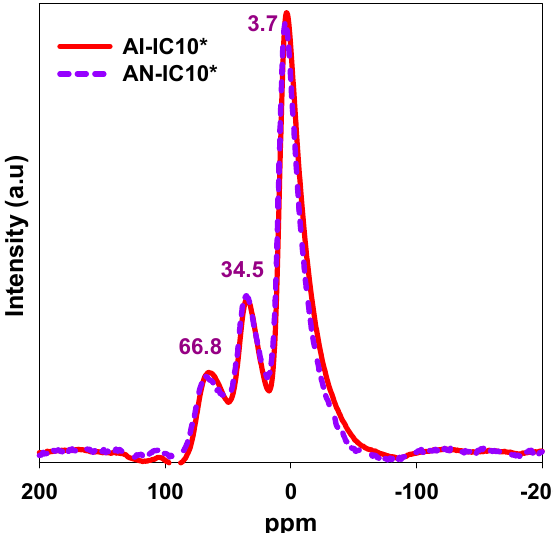
Figure 8. 27 Al-MAS NMR spectra of the AI-IC10* and AN-IC10* for extracted and calcined samples.